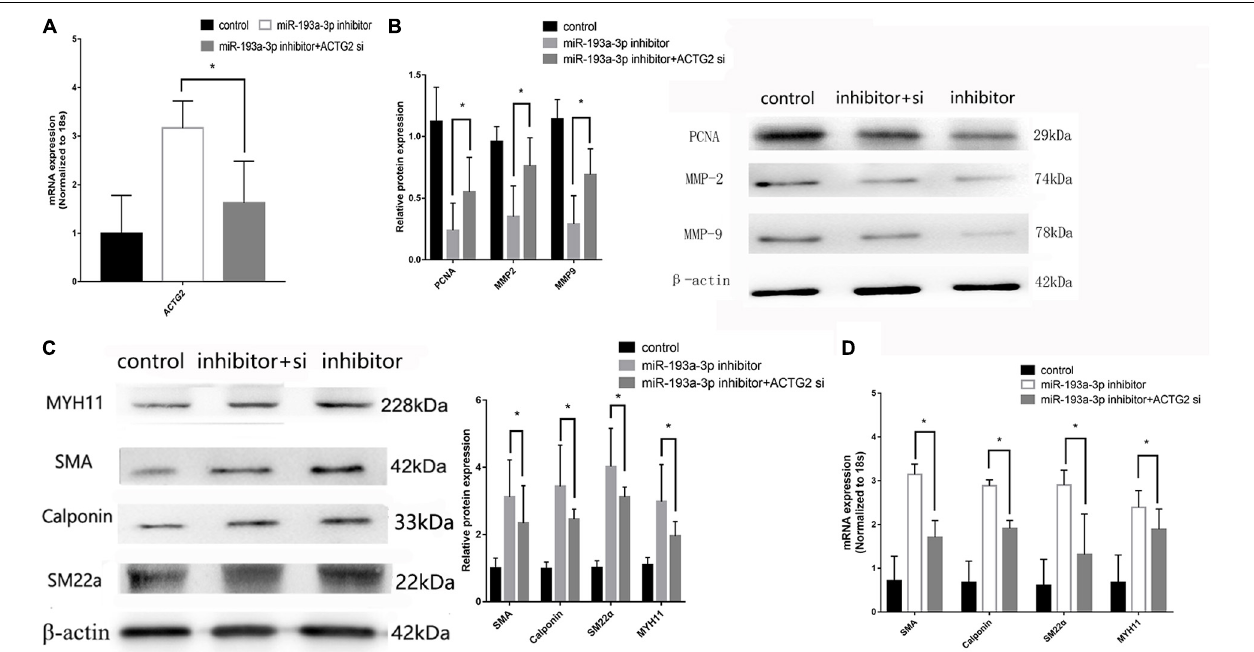
FIGURE 9 | Rescue experiments of ACTG2. (A) qRT-PCR presented over/downregulation of ACTG2 after transfection with ACTG2 vector and siRNA, respectively ( n = 3, * P ≤ 0.05 vs. control). (B) Western blot showed remedy PCNA, MMP2, and MMP9 after transfection with miR-193a-3p inhibitor + ACTG2 siRNA than transfection with miR-193a-3p inhibitor only ( n = 10, * vs. miR-193a-3p inhibitor). (C) Western blot analysis showed that low expression of VSMCs differentiation biomarkers in cells transfected with miR-193a-3p inhibitor + ACTG2 siRNA comparing to transfection with miR-193a-3p inhibitor only ( n = 3, * vs. miR-193a-3p inhibitor). (D) qRT-PCR presented remedy expression of VSMC differentiation